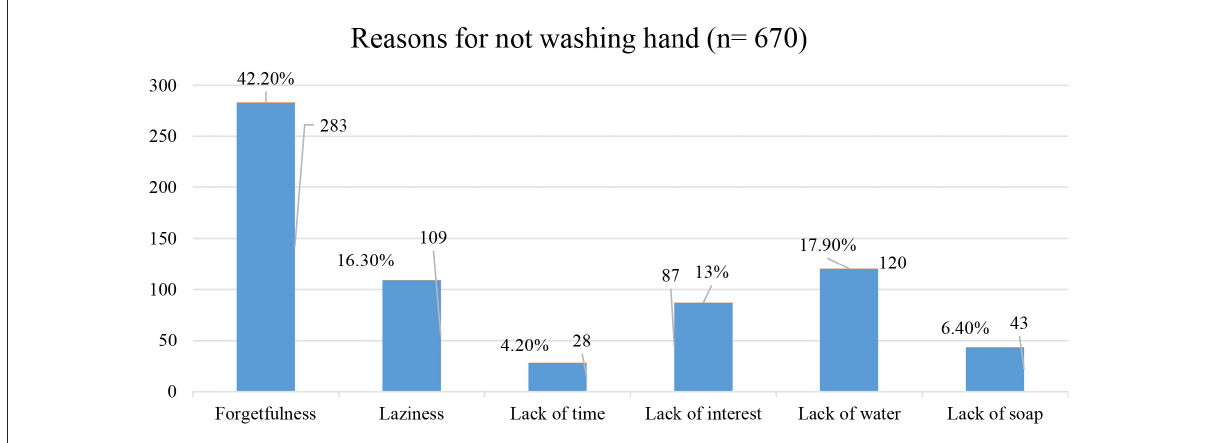
FIGURE2 Reported reasons for not washing hands in Harar town, eastern Ethiopia